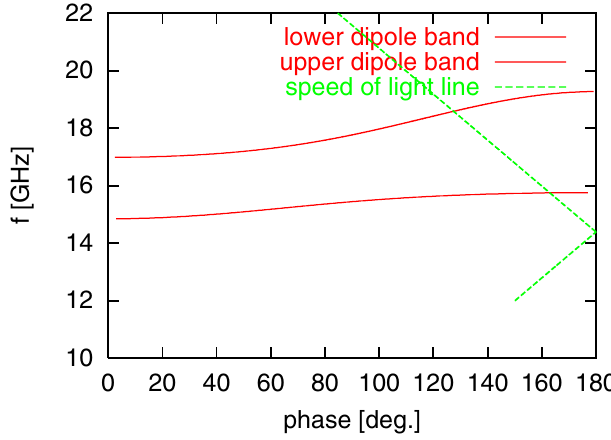
FIG. 5. (Color) Dispersion diagram of lowest two dipole bands in cell